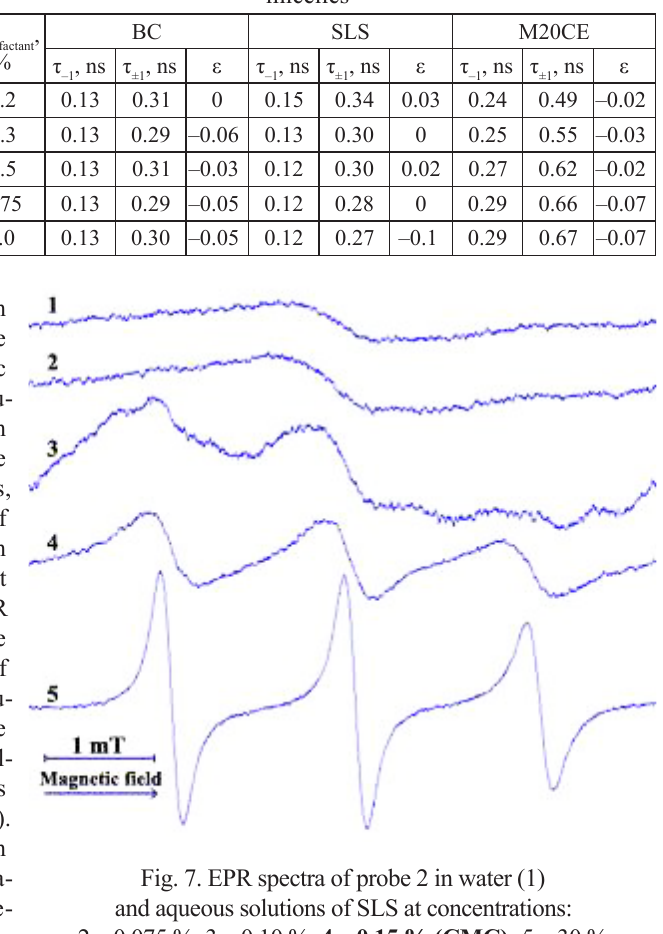
Fig. 7. EPR spectra of probe 2 in water (1) and aqueous solutions of SLS at concentrations: 2 – 0.075 %; 3 – 0.10 %; 4 – 0.15 % (CMC); 5 – 30